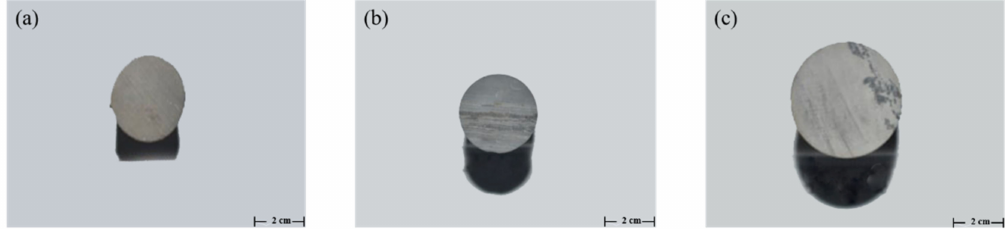
Figure 1. Images of inter-salt shale samples: A ( a ), B ( b ), and C ( c